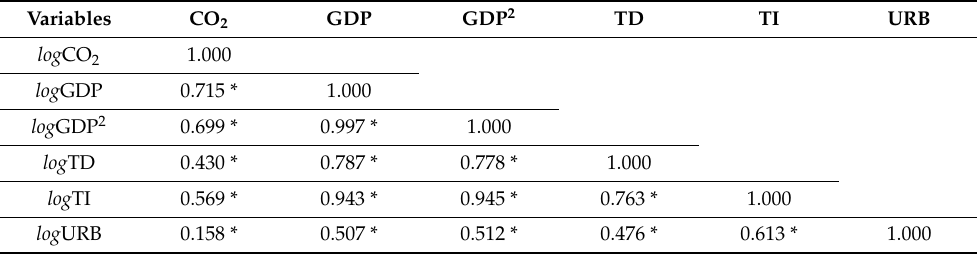
Table 3. Pairwise correlations.